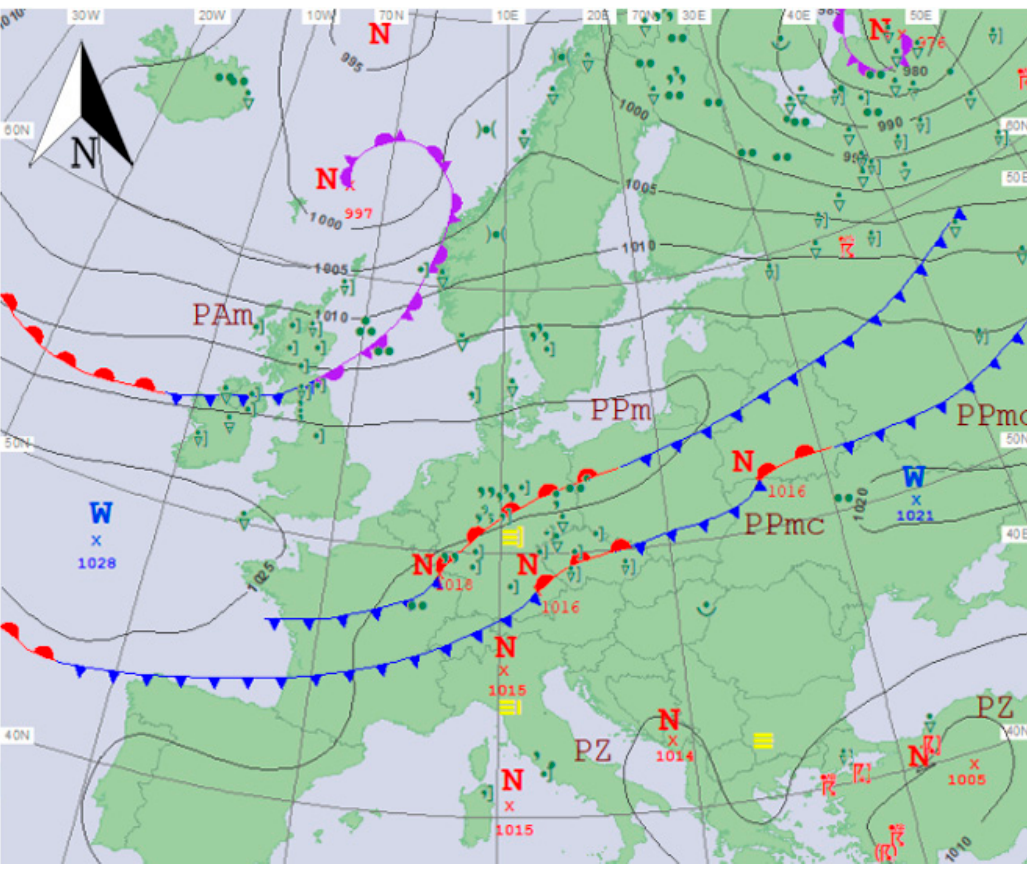
Figure 5. Europe synoptic map, September 13, 2018, at 12:00 UTC (based on Reference [42]). Remote Sens. 2019 , 10 , x FOR PEER REVIEW